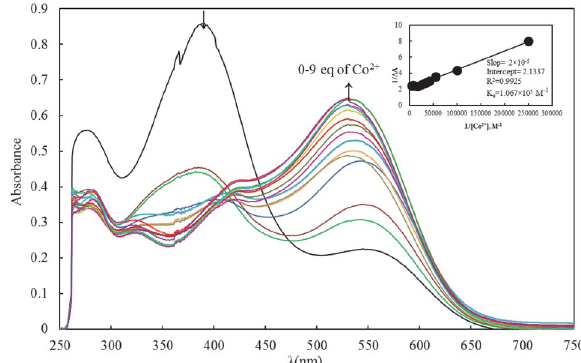
Fig. 8 . Changes in the UV–vis spectra of 2 (0.020 mM) upon titra- tion by Co(CH 3 COO) 2 in a DMSO solution, where the concentra-